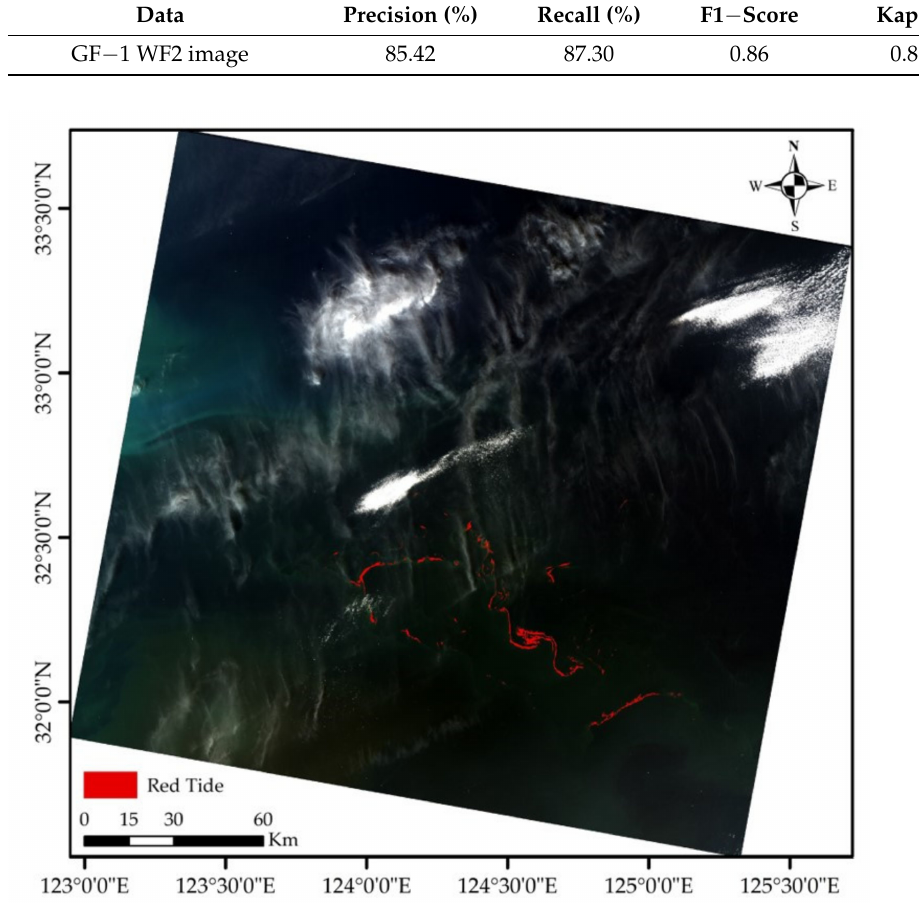
Figure 13. Red tide detection result using GF − 1 WF2 image. The red regions represent red